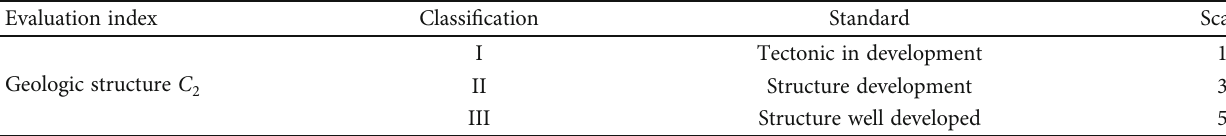
Table 5: Classi fi cation of geological structure.